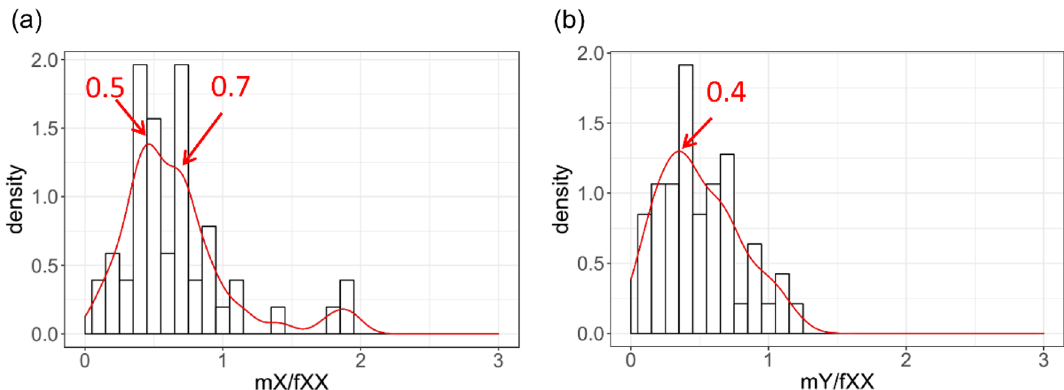
Figure 2. The distribution of relative transcript abundance of X-alleles ( a ) and Y-alleles ( b ) in male relative to their corresponding X alleles in female. SNPs were called by GATK Haplotypecaller and read counts were normalized by number of SNPs and the library size of each sample. Outliners are not shown. Bin size in histogram is 0.1. Red curve shows the kernel-smoothed density estimation. Peaks are highlighted with red